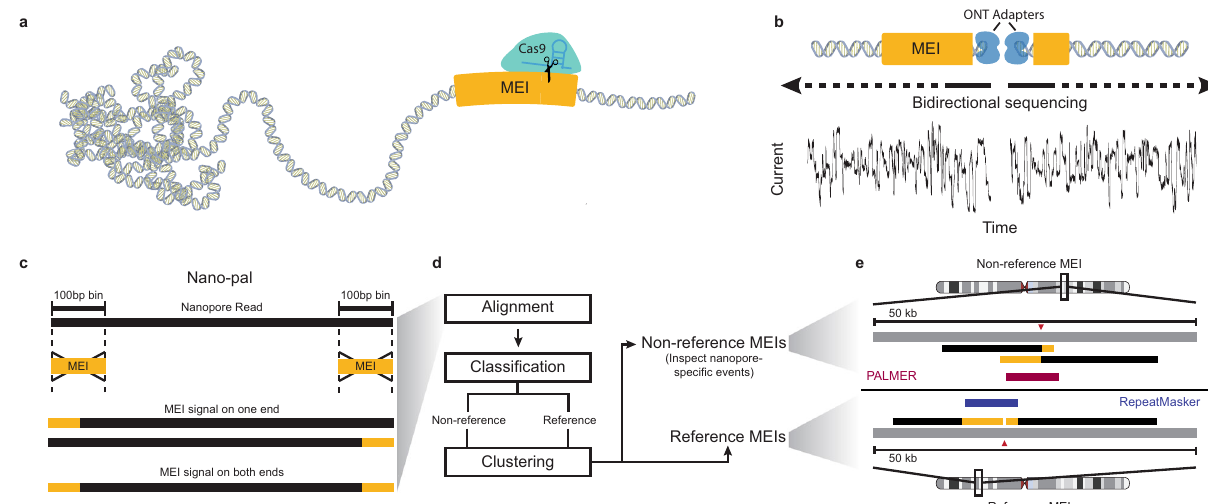
Fig. 1 A schematic Cas9 targeted enrichment and Nano-Pal pipeline for mobile elements using nanopore sequencing. a Puri fi ed genomic DNA (gDNA) is isolated by salting out and then extensively dephosphorylated. Dephosphorylated gDNA is incubated with the Cas9 ribonucleoprotein which is targeted to MEI subfamily-speci fi c sequences near the 3 ′ end of the element. Taq polymerase (not shown), and dATPs (not shown) monoadenylate DNA ends. b Cas9 cleaved sites are ligated with Oxford Nanopore Technologies (ONT) sequencing adapters and sequenced on a fl ow cell. Sequencing is bi-directional from the cleavage site. c Nano-Pal scans the nanopore sequencing reads (black bars) after Cas9 enrichment for MEI signal on one or both ends. The yellow bar represents MEI consensus sequence or MEI signals in pairwise comparison of Nano-Pal. d All reads with or without annotated MEI signal are imported into the downstream pipeline. Alignment, classi fi cation, and clustering processes are sequentially conducted. Nano-Pal identi fi es reference and non- reference MEIs followed by the inspection of nanopore-speci fi c non-reference MEIs (see “ Methods ” section). e Examples illustrating capture and alignment of reads containing non-reference L1Hs signal (top) and reference L1Hs signal (bottom). Aligned reads display a non-reference insertion (top) with L1Hs signal (yellow bar) and fl anking genomic sequence (black bar). MEI components of reads in non-reference insertions are displayed as overlapping (soft clipping) due to lack of reference genome MEI annotation (gray bar). Aligned reads display annotated reference L1Hs (bottom, yellow bar), fl anked